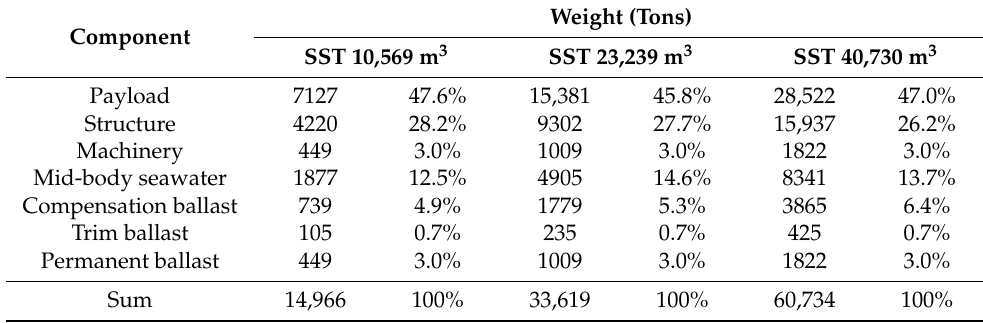
Table 6. Weight composition for individual SST design (CO 2 -filled